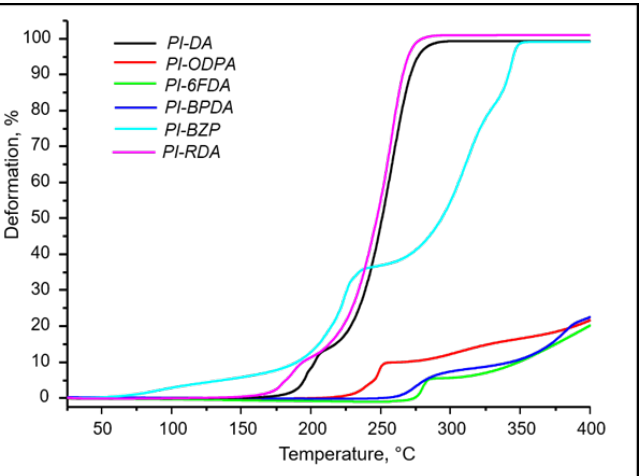
Figure 9. TMA curves of synthesized polyimides (heating rate of 5 °C/min in penetration mode with constant load 0.5 N).